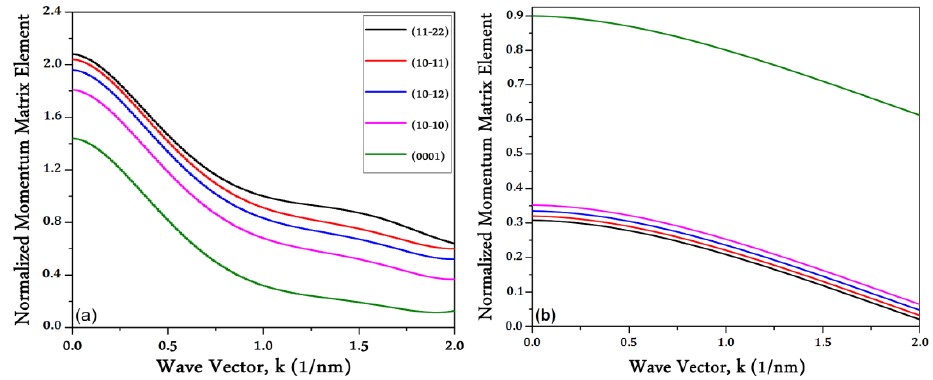
Figure 9. Momentum matrix elements normalized for ( a ) CB-HH transition and ( b ) CB-LH transition as a function of wave vector, k in different crystal orientations.